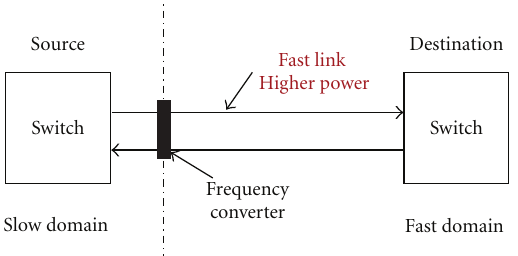
Figure 5: Placed closer to the slow clock domain. large burst sizes get a larger increment at each iteration. The value of α is set experimentally. A very low value would result in lot more solutions being explored, while requiring more numbers of